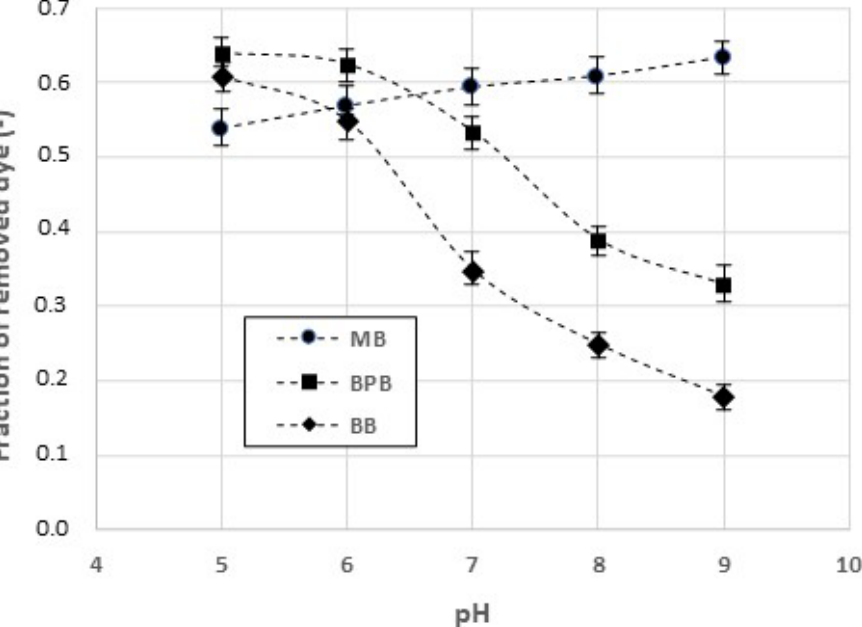
Figure 1. Amounts of methylene blue (MB), bromophenol blue (BPB), and Coomassie brilliant blue (BB) adsorbed on chitosan hydrogel. S/L ratio = 1/100, contact time = 120 min.